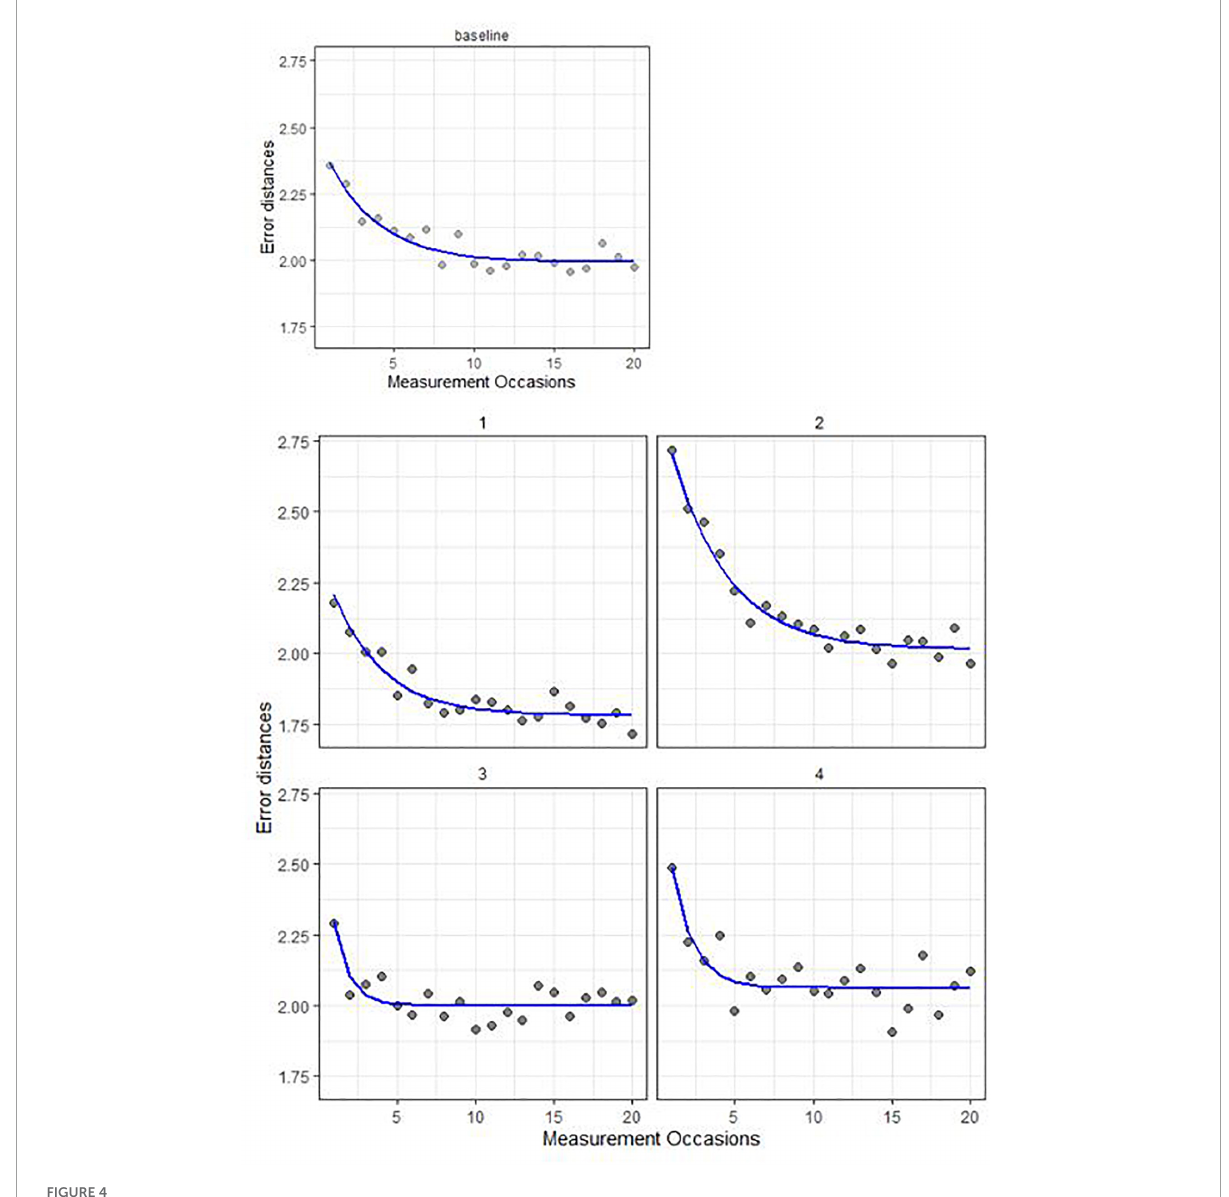
FIGURE4 Five synthetic participant’s data (gray dots) and model fit (solid line).